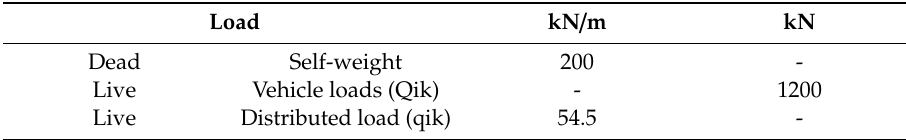
Table 1. Loads and actions.